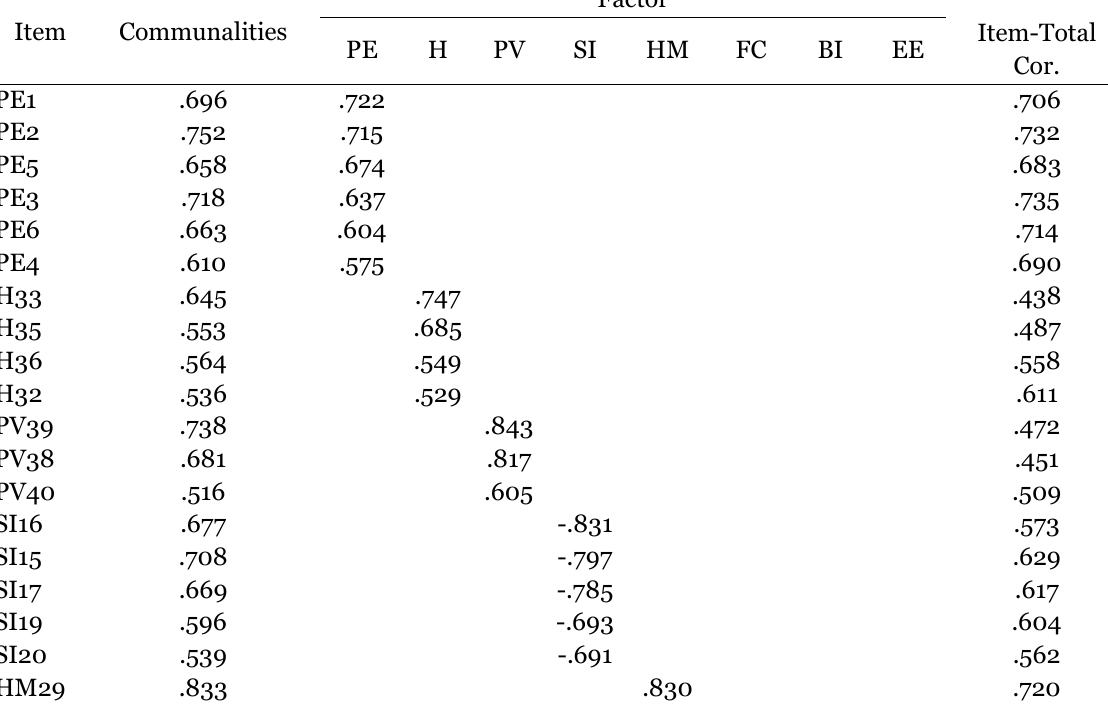
Results of Exploratory Factor Analysis Using Oblimin Rotation With Kaiser Normalization